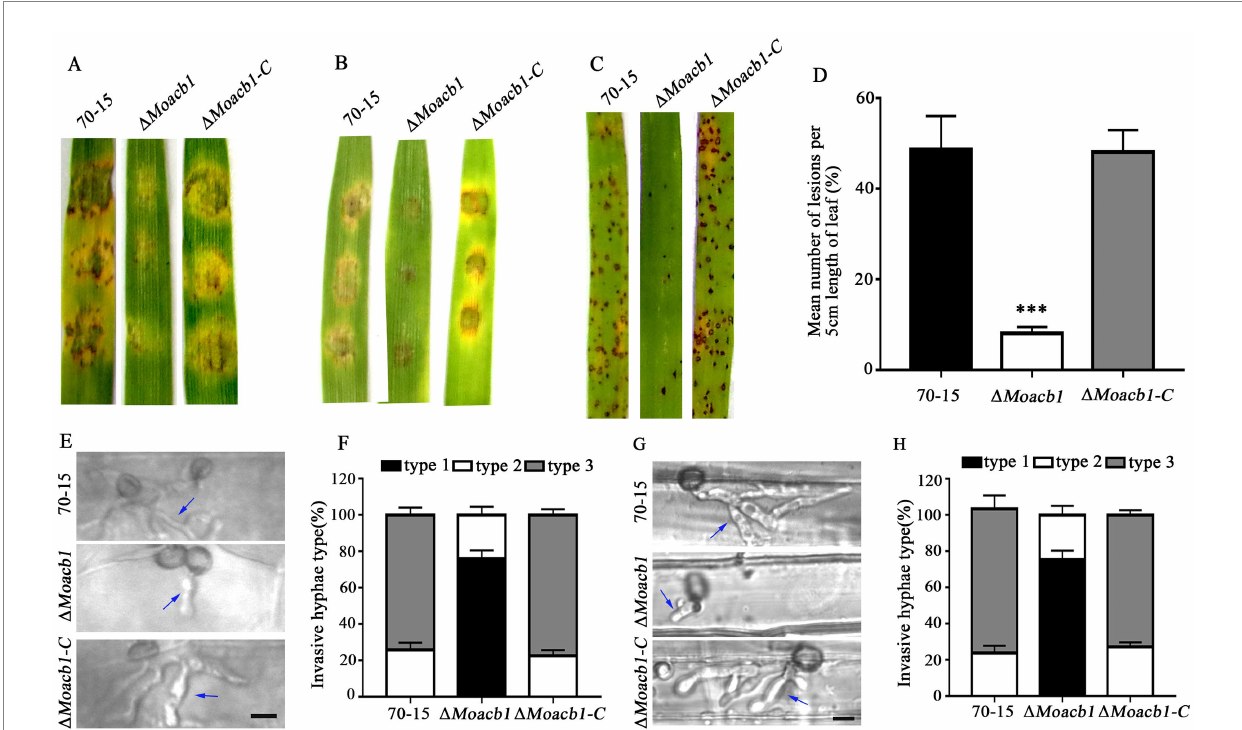
FIGURE 4 MoAcb1 affects the pathogenicity of M. oryzae . (A) Mycelial plugs of the 70-15, ∆ Moacb1 and ∆ Moacb1-C strains were placed on isolated barley leaves, and photographs of pathogenicity were taken 4 days later. (B) Conidial suspensions of the 70-15, ∆ Moacb1 and ∆ Moacb1-C strains were inoculated on isolated barley leaves, and photographs of pathogenicity were taken 4 days later. (C) Conidial suspensions of the 70-15, ∆ Moacb1 and ∆ Moacb1-C strains were sprayed on isolated rice leaves, and photographs of pathogenicity were taken 5 days later. (D) Quantification of the lesions number per 5 cm length of rice leaf. Asterisk represents significant difference ( p < 0.001). (E) Pictures were taken of the leaves infected by wild type 70-15, the ∆ Moacb1 mutant and complement strain at 36 hpi. The arrow points to the invasive hyphae. (F,H) Infection types produced by different strains (70-15, ∆ Moacb1 and ∆ Moacb1-C ) were counted, and the experiment was repeated three times with three replicates each time. (G) Pictures were taken of 70-15, ∆ Moacb1 and ∆ Moacb1-C strains infecting leaf sheath at 36 hpi. The arrow points to the invasive hyphae.